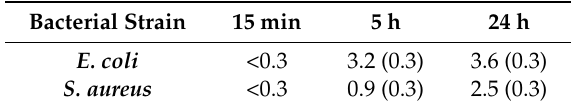
Table 1. Microbicidal effect (ME) values 1 for GLASS-PEI-TRI